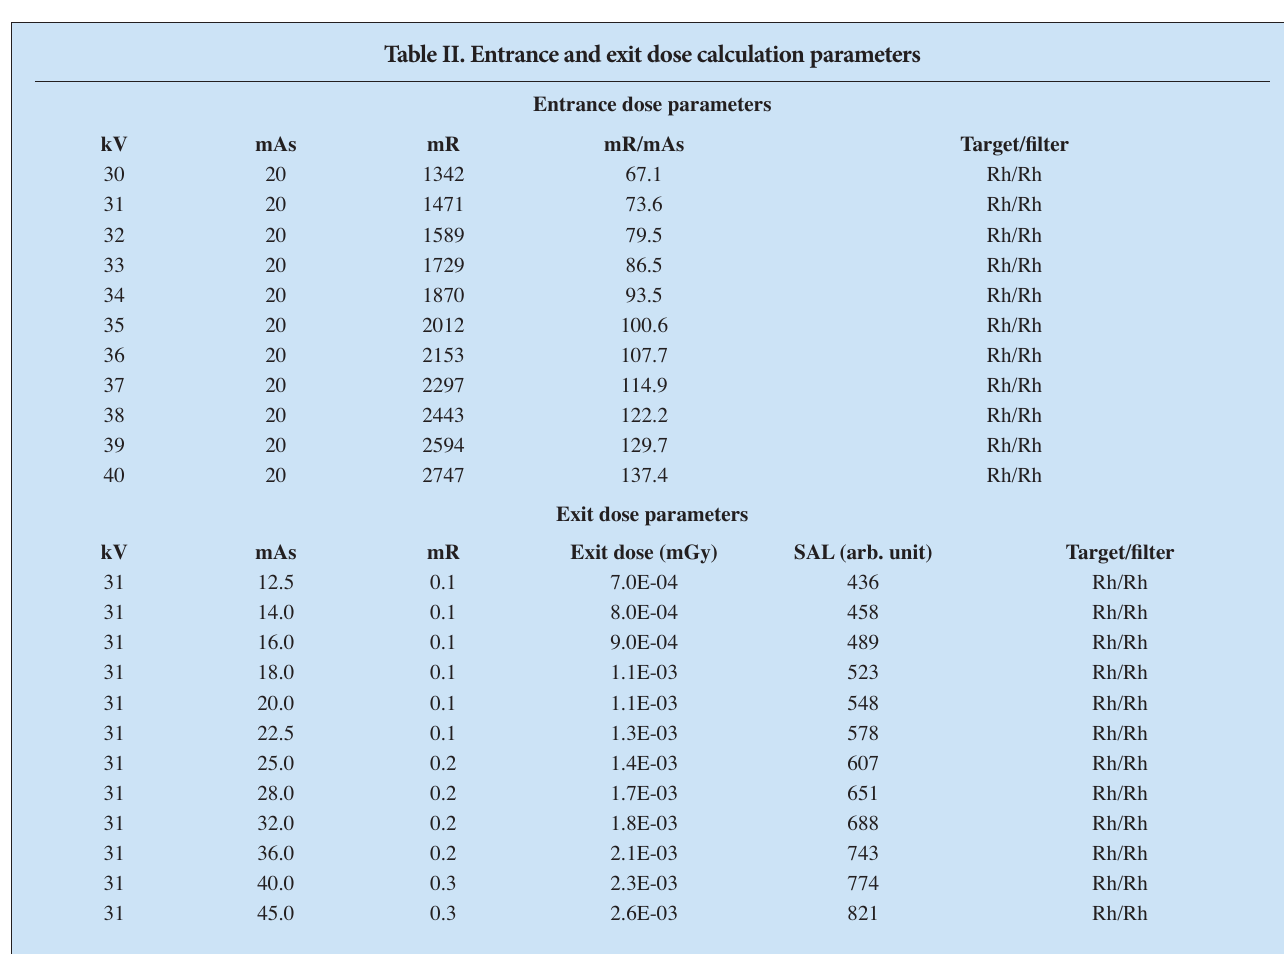
Table II. Entrance and exit dose calculation